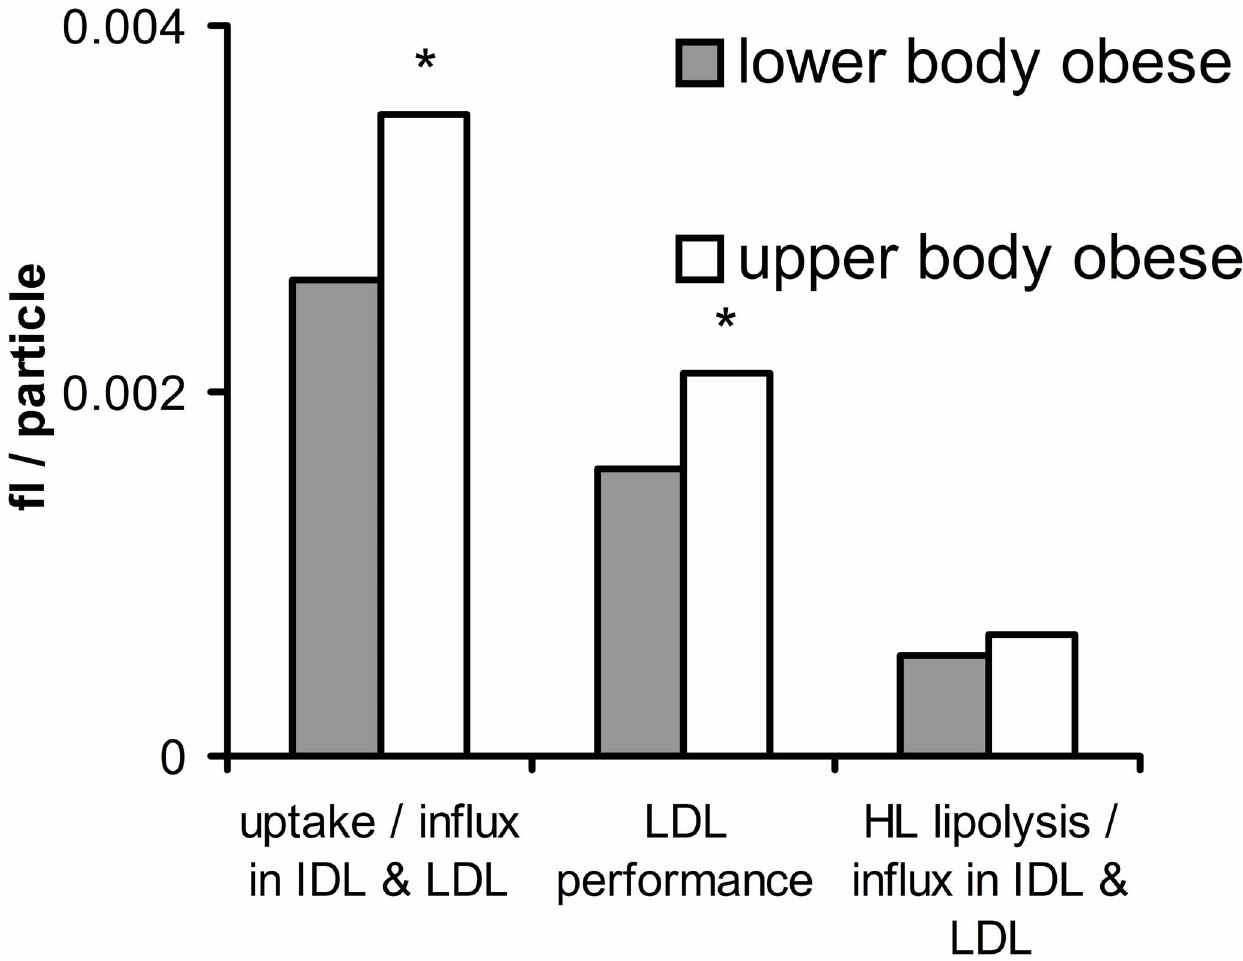
Figure 7. Ratios between average IDL and LDL metabolism parameters in lower body obese (LBO) versus upper body obese (UBO) subjects. LDL performance is the average of the two ratios shown to the sides. ‘‘fl/particle’’ is the unit of all three ratios. * Indicates a significant difference in two-way ANOVA between LBO and UBO subjects, with p , 0.05. p-values of the significant measures are: uptake/influx in IDL and LDL (p=0.012); LDL performance